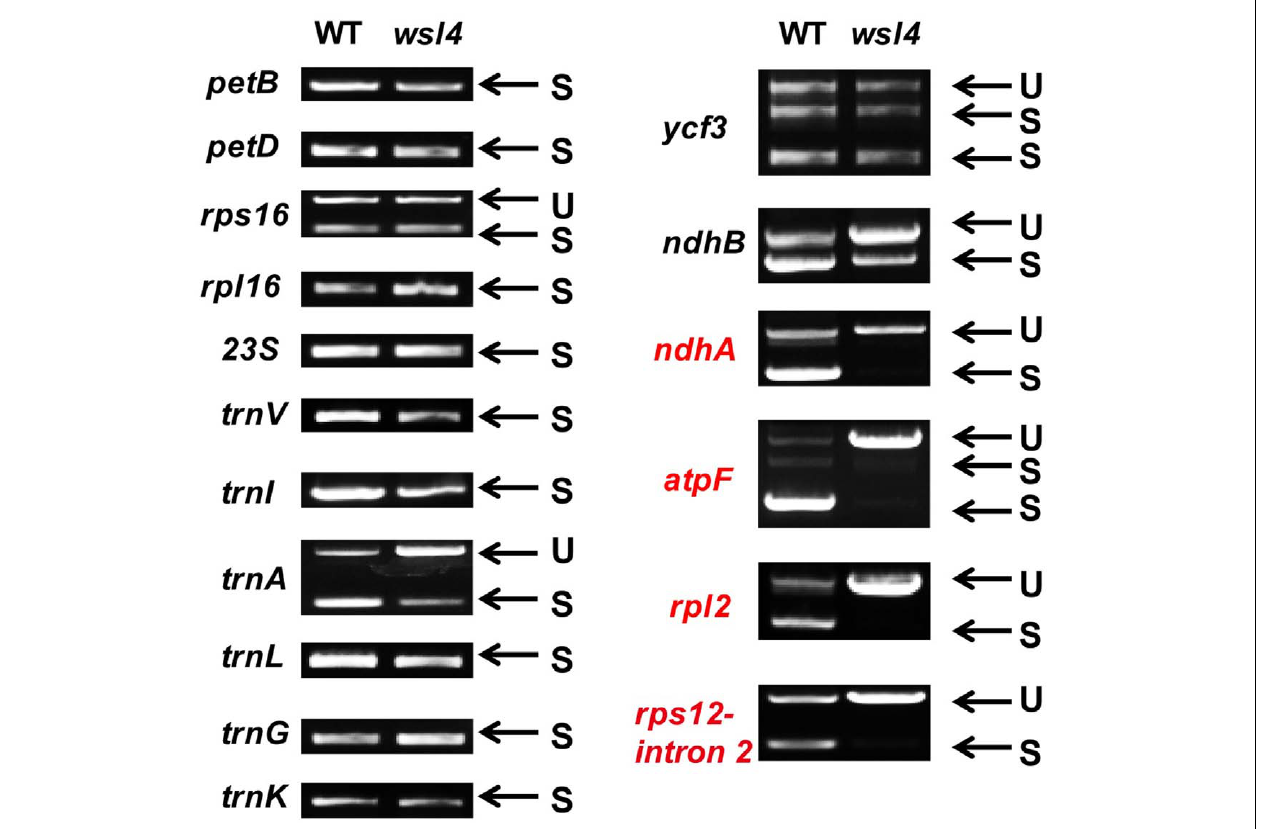
FIGURE 8 | Splicing analyses of rice chloroplast transcripts in WT and wsl4 mutant (white striped sectors). Gene transcripts are labeled at the left. Spliced (S) and unspliced (U) transcripts are shown at the right. RNA was extracted from L3-3 of WT and wsl4 mutant plants grown in a growth chamber at L30/D25. L3-3 indicates the third leaf at the three-leaf